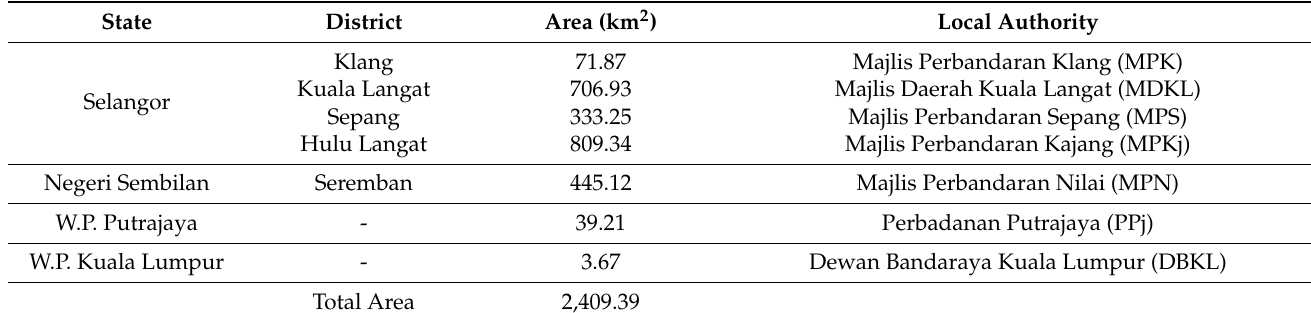
Table 9. Local authorities and its administrative areas at Langat River Basin, Malaysia